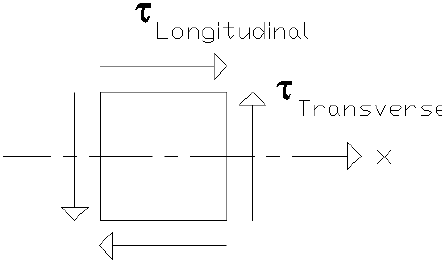
Figure 3. Infinitesimal shear stress element.